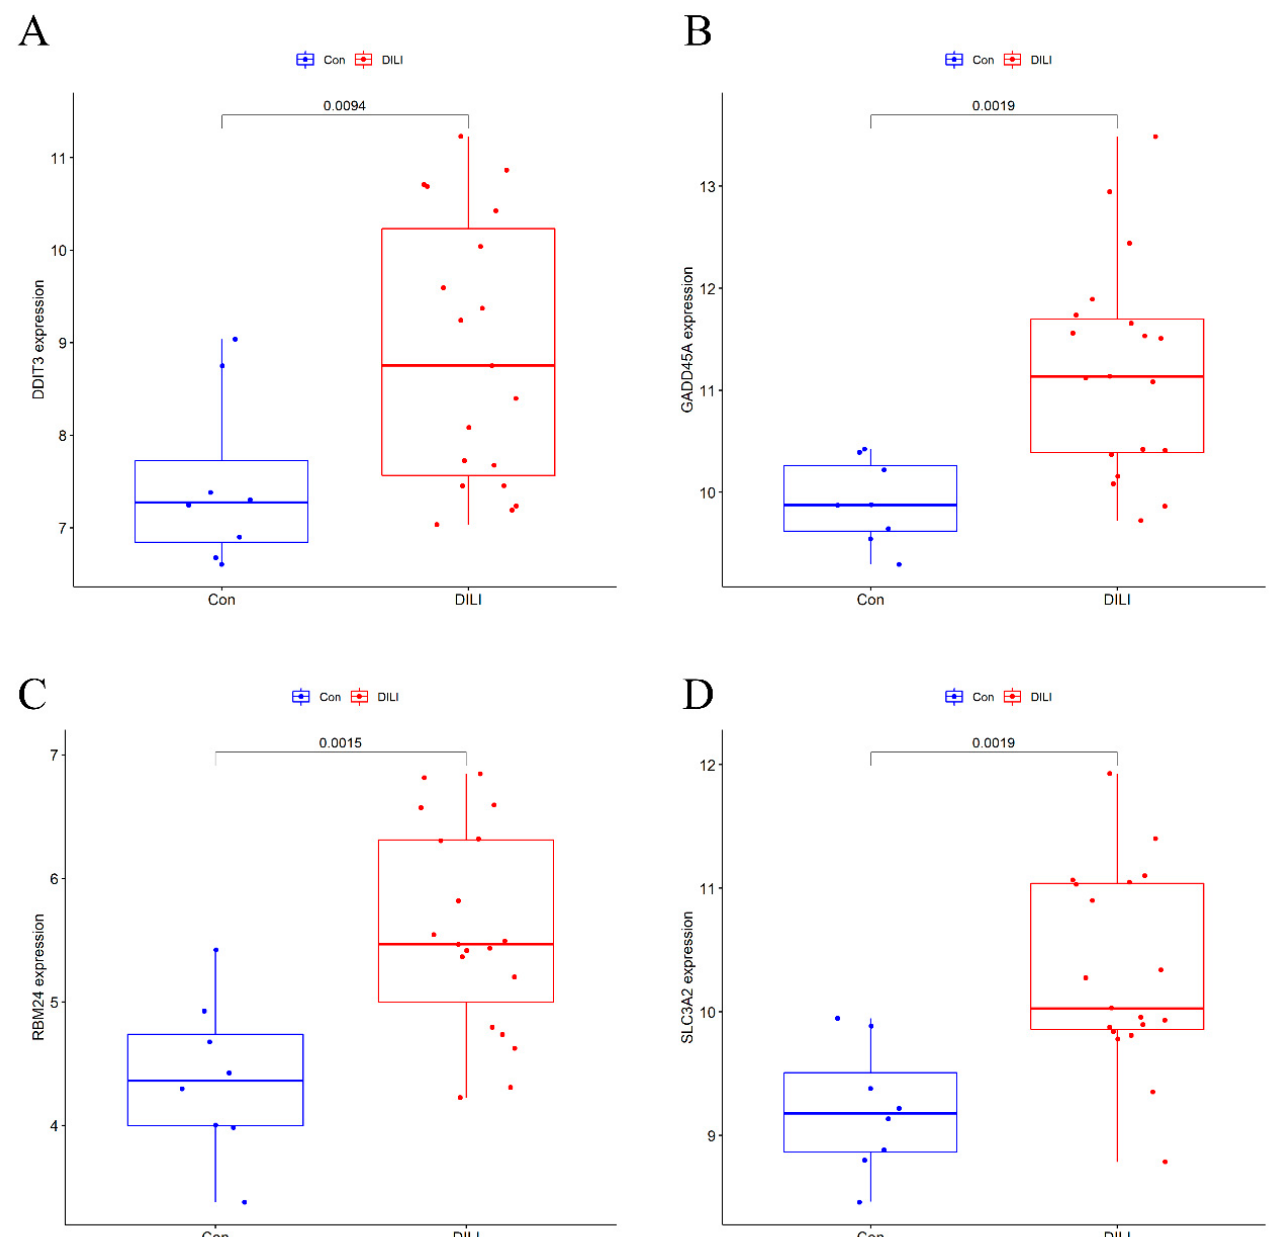
Figure 5. Results of a comparison of 4 candidate DEGs in testing set. Compared with Con, p < 0.05 as statistic difference. ( A ) The expression of DDIT3 between the Control and DILI groups in the testing set; ( B ) The expression of GADD45A between the Control and DILI groups in the testing set; ( C ) The expression of RBM24 between the Control and DILI groups in the testing set; ( D ) The expression of SLC3A2 between the Control and DILI groups in the testing set.